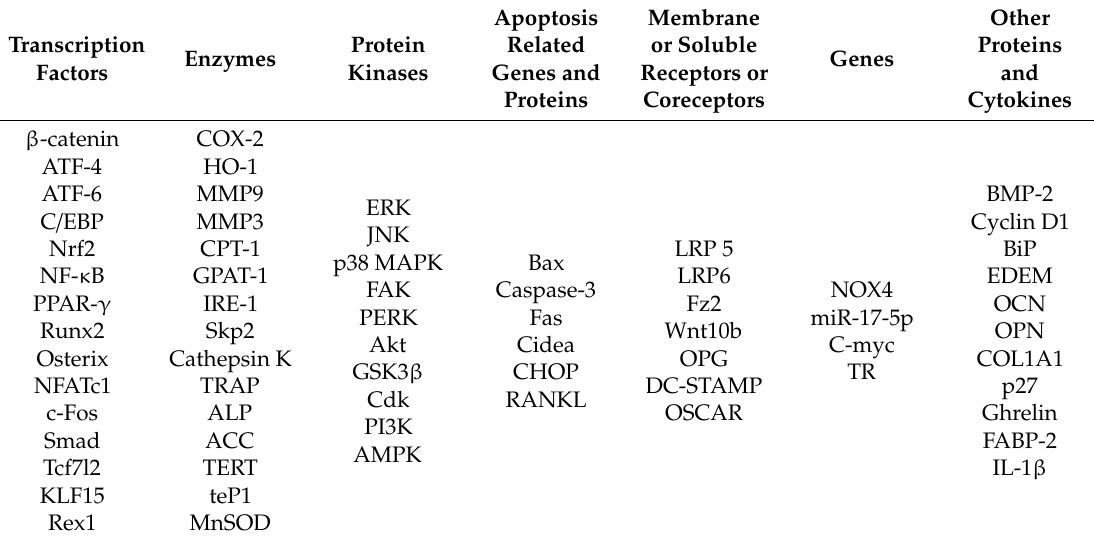
Table 1. Biomolecules involved in the mesodermal di ff erentiation of mesenchymal stem cells (MSCs) by